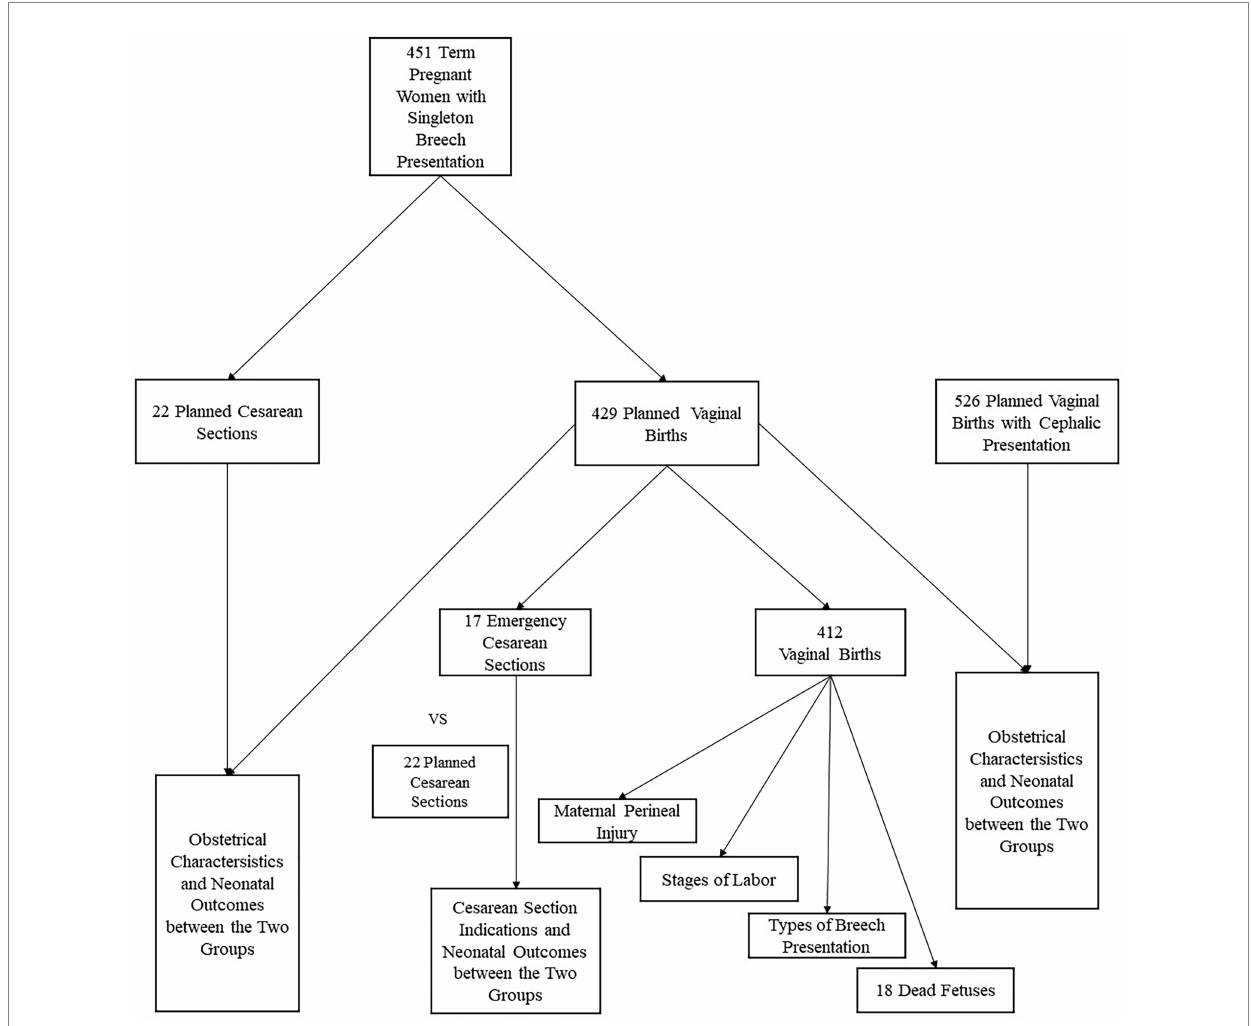
Figure 4. Of the 526 cephalic births collected, 24 were converted to emergency CS (4.6%), similar to breech births